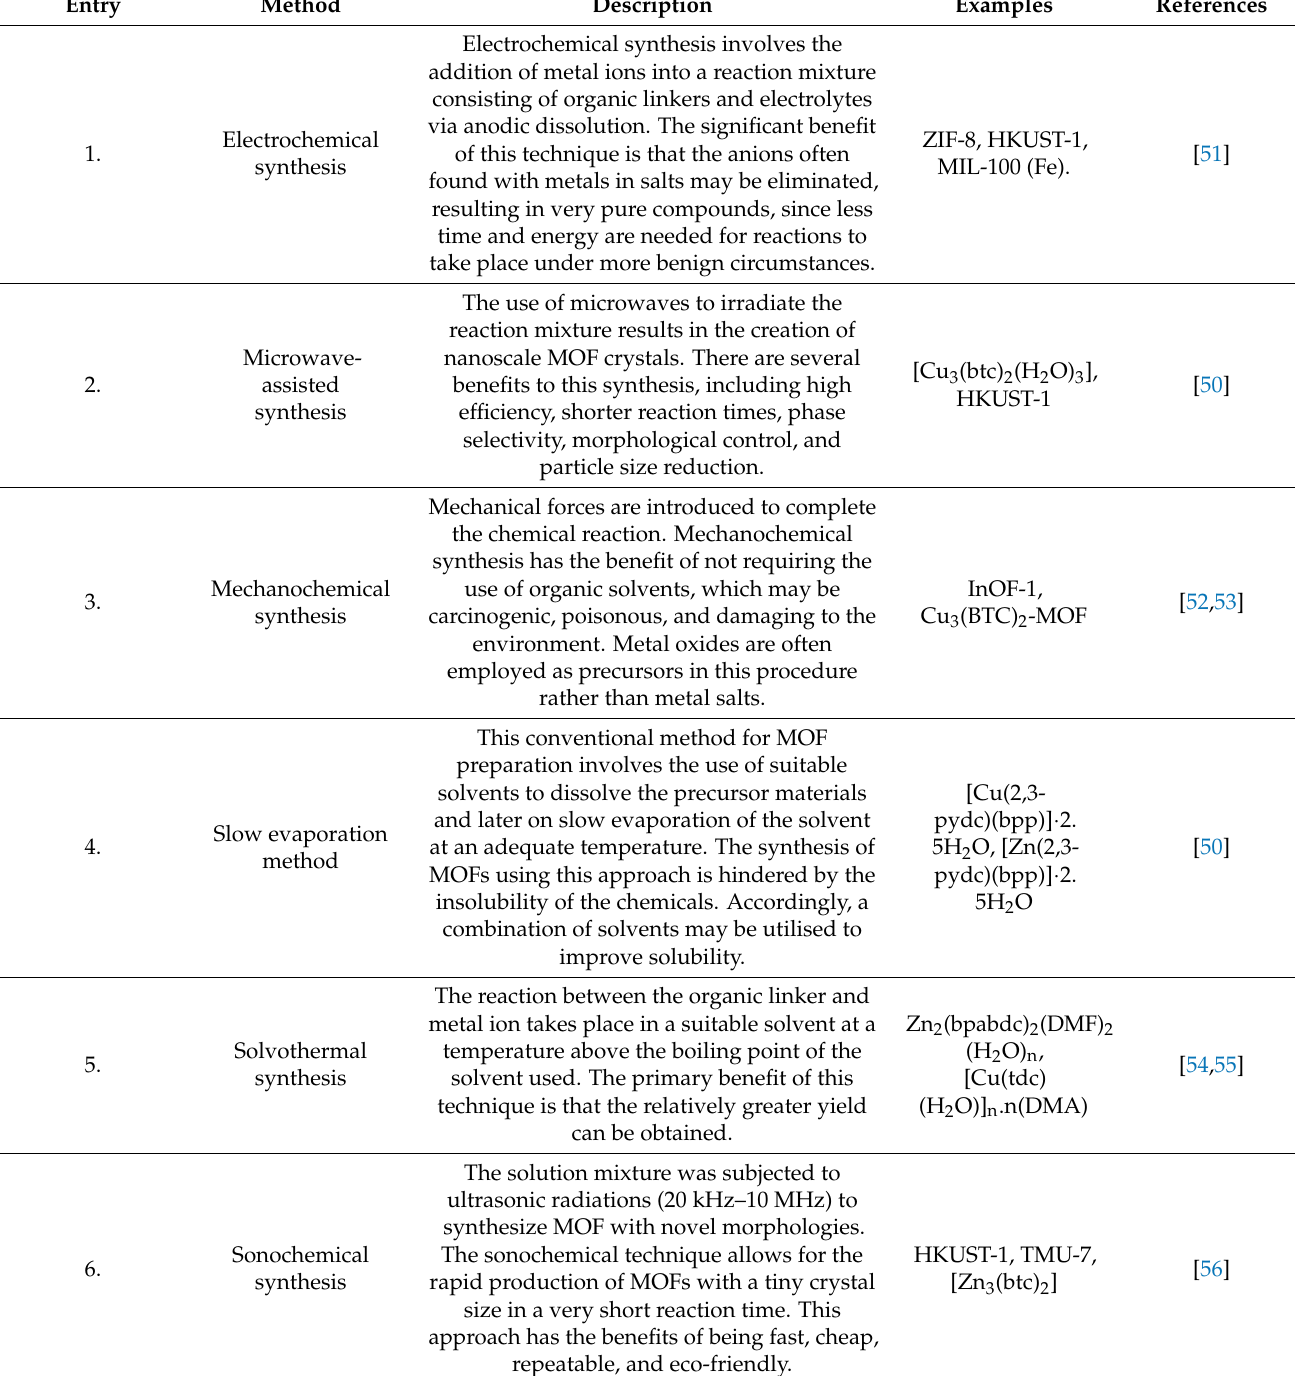
Table 2. General methods for synthesis of